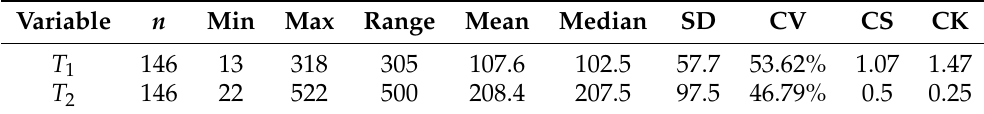
Table 1. Descriptive statistics for Chilean PM data using PM2.5 and PM10 24-h levels (in µ g/Nm 3 ) recorded for the Pudahuel monitoring station during the CEM period. Santiago, Chile 2015.